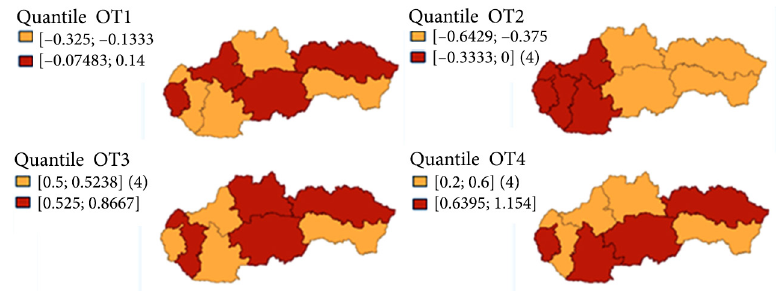
Figure 1. Results of spatial autocorrelation testing in case of Slovakia (source: own